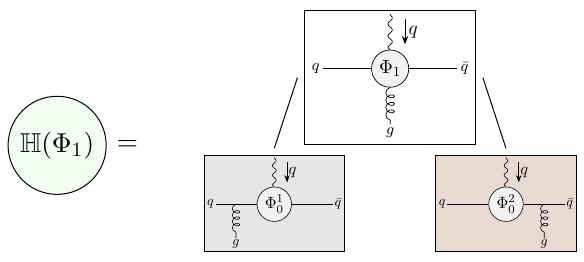
Figure 4 . Histories for one additional parton: the gluon can be recombined with the other partons in two distinct